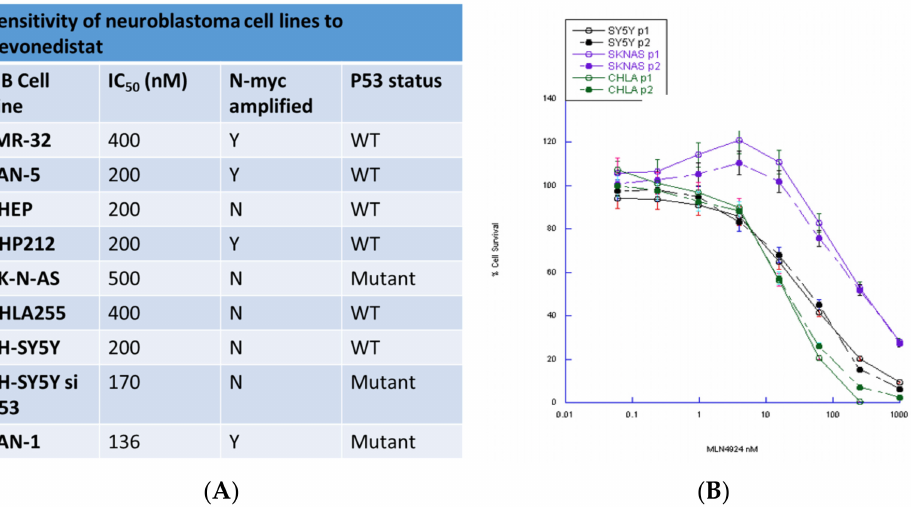
Figure 1. Sensitivity of neuroblastoma cell lines to pevonedistat. ( A ) Summary of neuroblastoma cell lines. ( B ) Dose- response curves for representative cell